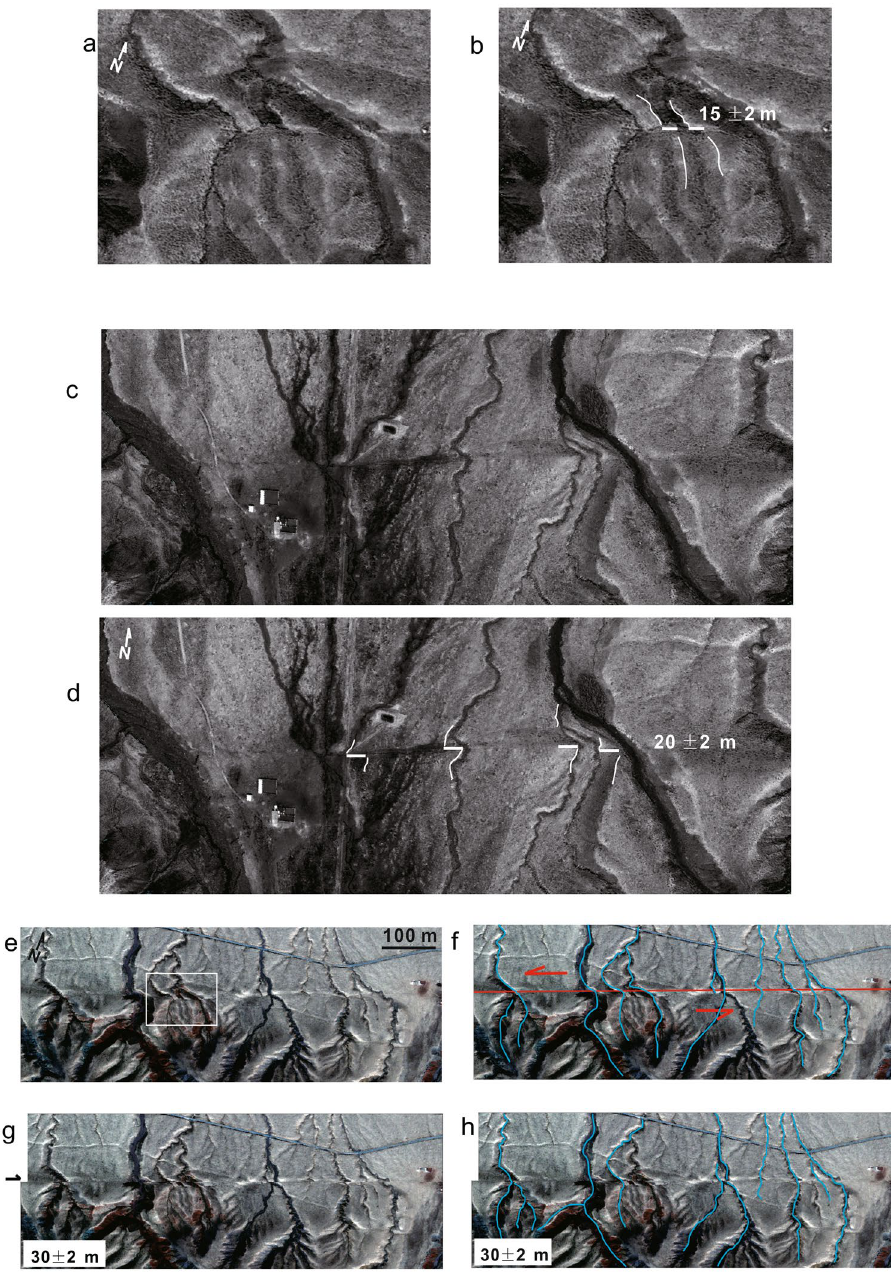
Figure 9. Reconstructions of cumulative offsets based on the Pleiades satellite image. Locations of a and b were indicated as white box in e . See locations of c , d and e – h in Fig. 3. Cumulative offset of 15 ± 2 m, 21 ± 2 m and 30 ± 2 m were